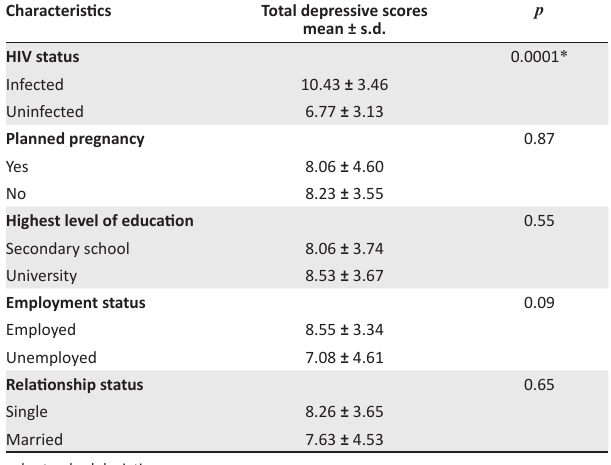
TABLE 2: Associations between socio-demographic and clinical factors and total depressive scores on the Edinburgh Depression Scale. Characteristics Total depressive scores mean ± s.d.